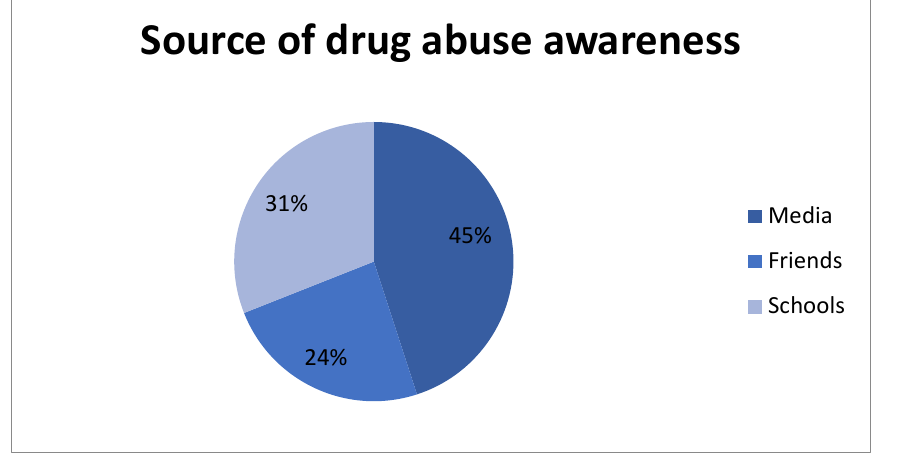
Figure 4. The sources of information Overview of the Existing